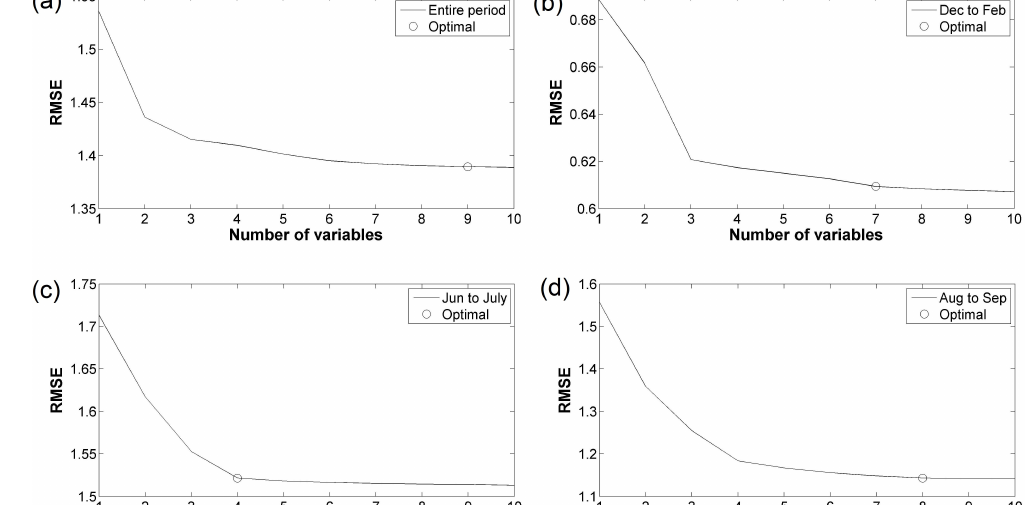
y = − 33 . 7038 + ( 0 . 0050 × O 3 ) + ( 0 . 0387 × SO 2